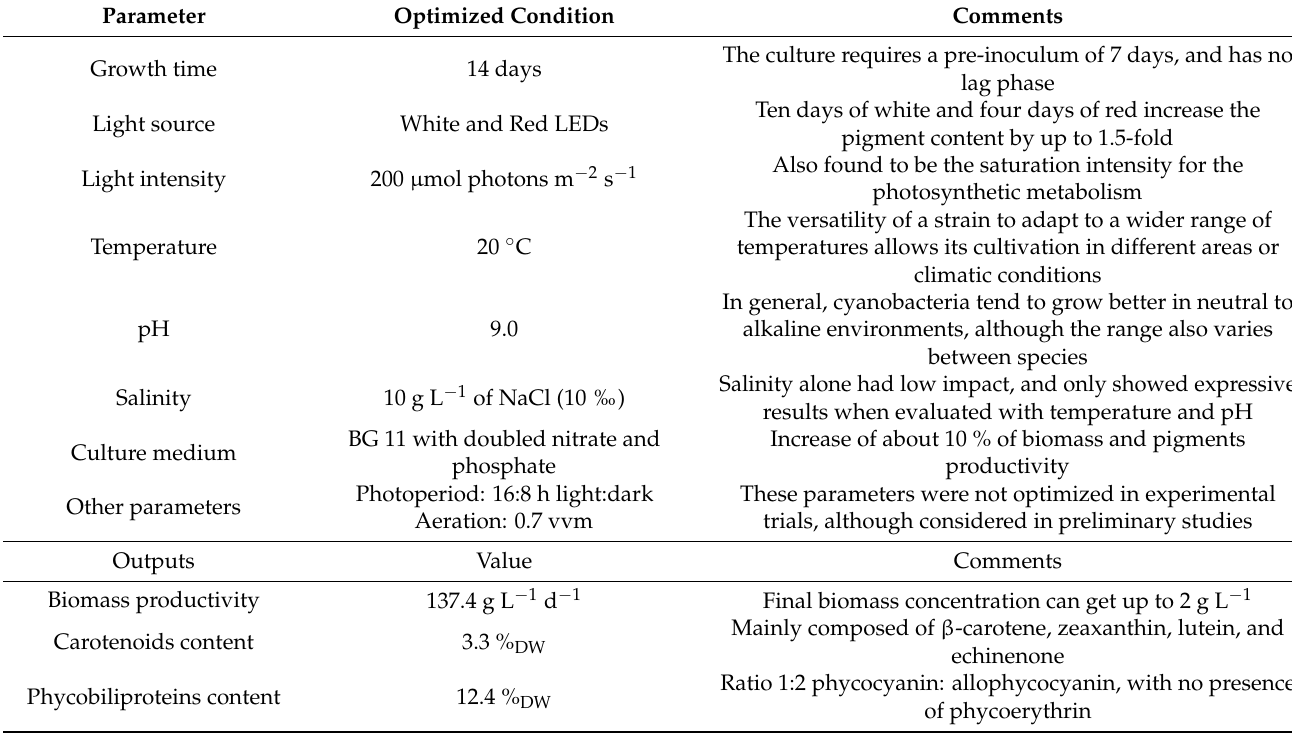
Table 1. Optimized parameters for Cyanobium sp. pigments production and final biomass output